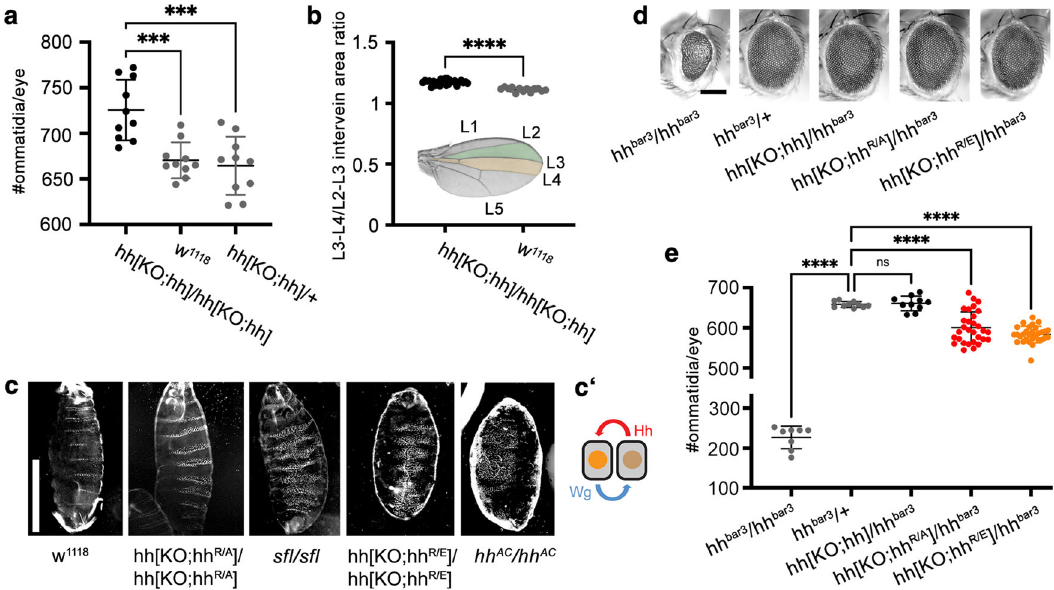
Fig. 2 | Opposing phenotypes of fl ies expressing hh versus hh R/A or hh R/E under endogenouspromotorcontrol.a Quanti fi cationofthenumbersofommatidiaper eye in female fl ies. Hh biofunction in eye disks of fl ies homozygous for transgenic hh (in hh[KO;hh]/hh[KO;hh] fl ies) is increased over that in w 1118 or heterozygous controls. Statistical signi fi cance was determined by one-way ANOVA followed by Dunnett ’ s multiple comparison test. n =10 for each genotype, F =13.6. Error bars represent standard deviation. *** p ≤ 0.0004. Source data are provided as a Source Data fi le. b Inset: Hh produced in the posterior compartment of the wing disc directlypatternstheL3-L4interveinarea(orange)andindirectlypatternstheL2-L3 intervein area (green). Quanti fi cation of L3-L4/L2-L3 intervein areas revealed sig- ni fi cantly increased patterning activities of transgenic Hh. Statistical signi fi cance was determined by unpaired t -test (two-tailed). n =13 wings for w 1118 and n =27 for hh[KO;hh]/hh[KO;hh], **** p <0.0001. L1-5 indicate the fi ve longitudinal Drosophila wing veins. Source data are provided as a Source Data fi le. c Segment phenotype hh bar3 . Error bars represent standard deviation. F =357. **** p ≤ 0.0001, ns: p =0.99.